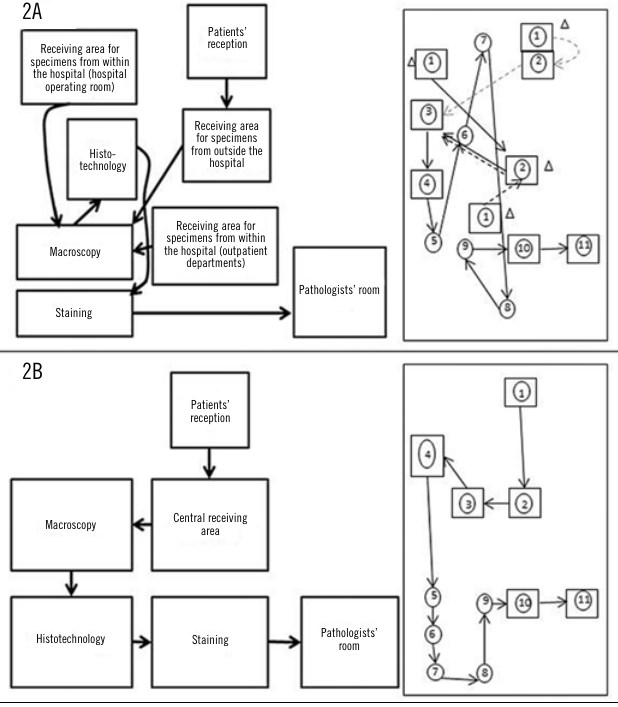
figuRE 2 − Walking pattern of the employees at PL-ICC (Spaghetti diagram) A) Spaghetti diagram of PL-ICC in 2013; B) actual Spaghetti diagram of PL-ICC, after laboratory renovation. In the upright direction of each schematic representation of the walking patterns, the representation of activities follows as if in the architectural plan of the laboratory. Scheme for the identification of the mapped tasks: 1) reception of the biological material; 2) reception of exam requests; 3) fixation; 4) macroscopy; 5) tissue processing; 6) embedding; 7) cutting; 8) staining; 9) assembly; 10) checking quality and definition of batches for each pathologist; 11) microscopy; ○ : biological material; □ : printed exam request. The arrow represents the workflow from each specimen entrance place: → : common flow; → : operating room; ---›: outpatient departments; ---› : outside the hospital; ∆: critical problems (Figure 2A, 2013 Spaghetti diagram); or → : actual unidirectional workflow after Lean philosophy implementation (Figure 2B, 2014 Spaghetti diagram)